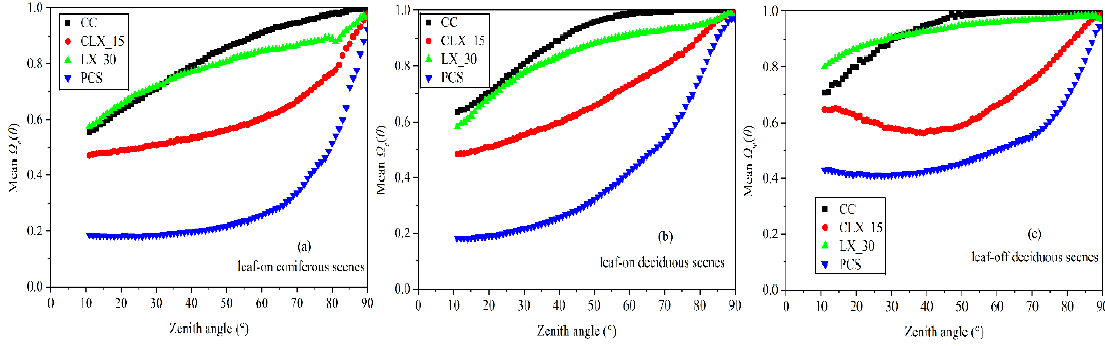
 and ( )  derived using CC, CLX_15, LX_30, and PCS at leaf-on Figure 6. Mean ( ) Figure 6. Mean Ω e ( θ ) and Ω w ( θ ) derived using CC, CLX_15, LX_30, and PCS at leaf-on coniferous e w scenes, ( a ) leaf-on deciduous scenes ( b ) and leaf-off deciduous scenes ( c ), coniferous scenes, ( a ) leaf-on deciduous scenes ( b ) and leaf-off deciduous scenes ( c ), respectively. PAI or WAI estimates of the seven Compared with the differences between the mean e e